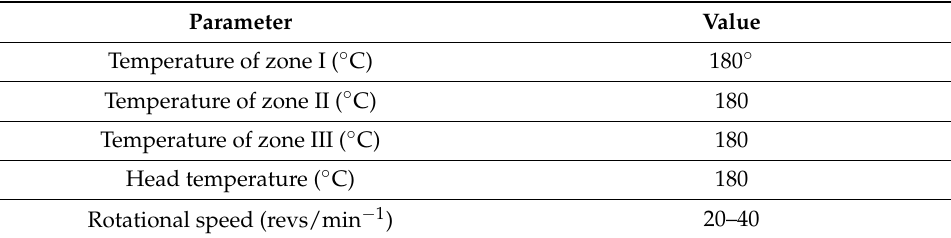
Table 3. Plasticizing temperature during extrusion of polymer